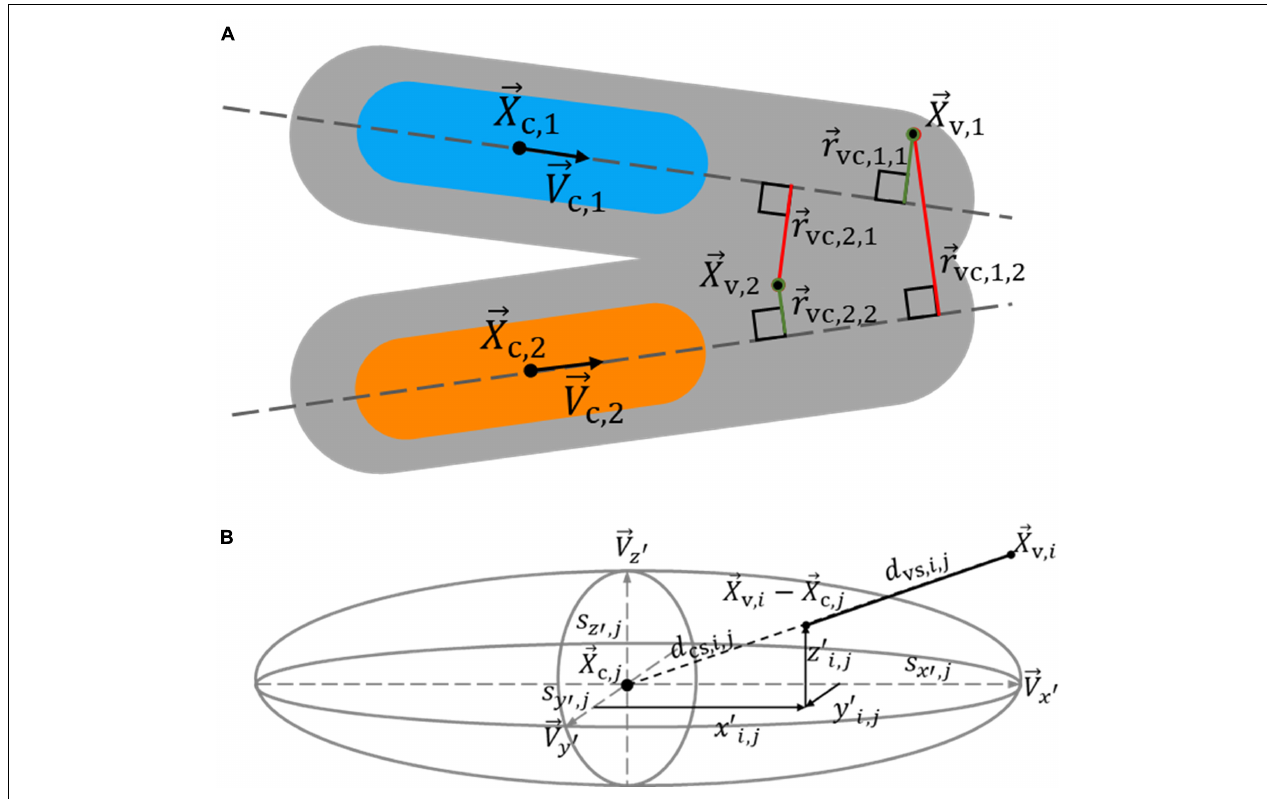
FIGURE 6 | Determination of the likelihood that voxels excluded from spectral clustering belong to a nucleus core. An excluded voxel is assigned to a nucleus core based on its distance to core centerlines and the distance to core surfaces, as estimated by an ellipsoid. (A) The shortest distance from excluded voxels 1 and 2 to core centerlines 1 and 2 influences which core they likely belong to. Since is more likely to belong to core 1 than 2, shown in blue and orange, respectively. Voxel 2 more likely belongs to core 2 than 1, as (B) The graph shows the path from excluded voxel i to the surface of core j, as estimated by an ellipsoid, in the direction of the core centroid. A voxel is more likely to belong to a core it has a shorter distance to its surface